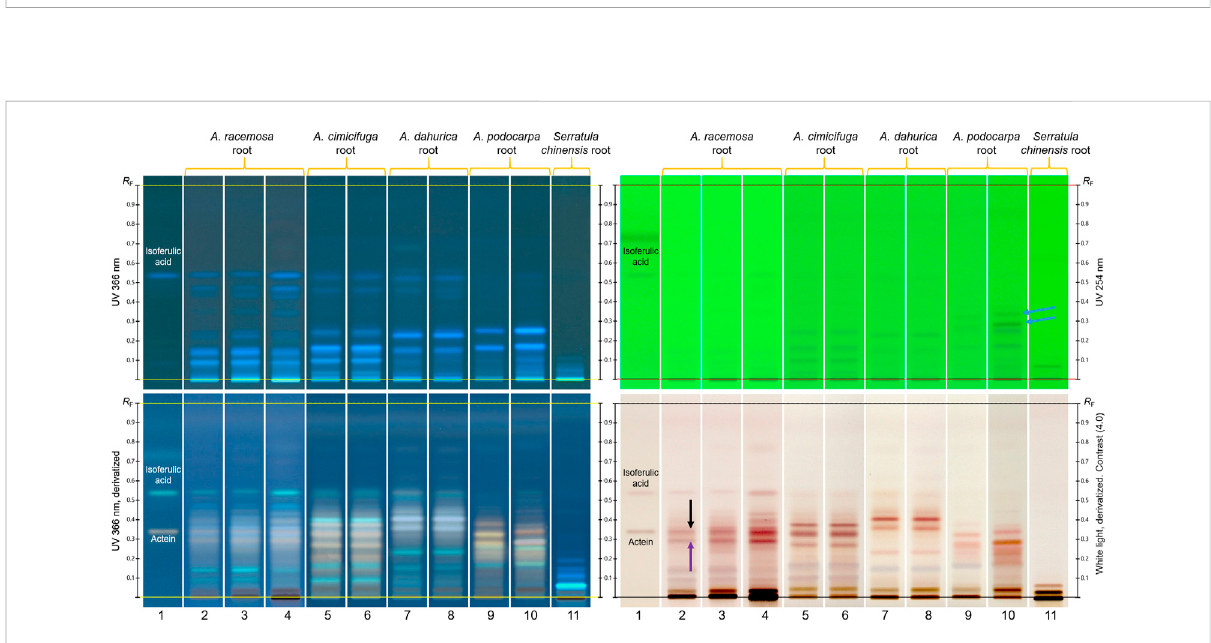
FIGURE 5 TypicalHPTLC fi ngerprintsof Actaearacemosa andcommonadulterantspriorto(top)andafterderivatization(bottom).Lefttrackineachimage shows the chromatogram of the reference substances. Blue arrows: zones characteristicof A. podocarpa root; black arrow: zone due to actein in A. racemosa ; purple arrow: zone due to 26-deoxyactein in A. racemosa